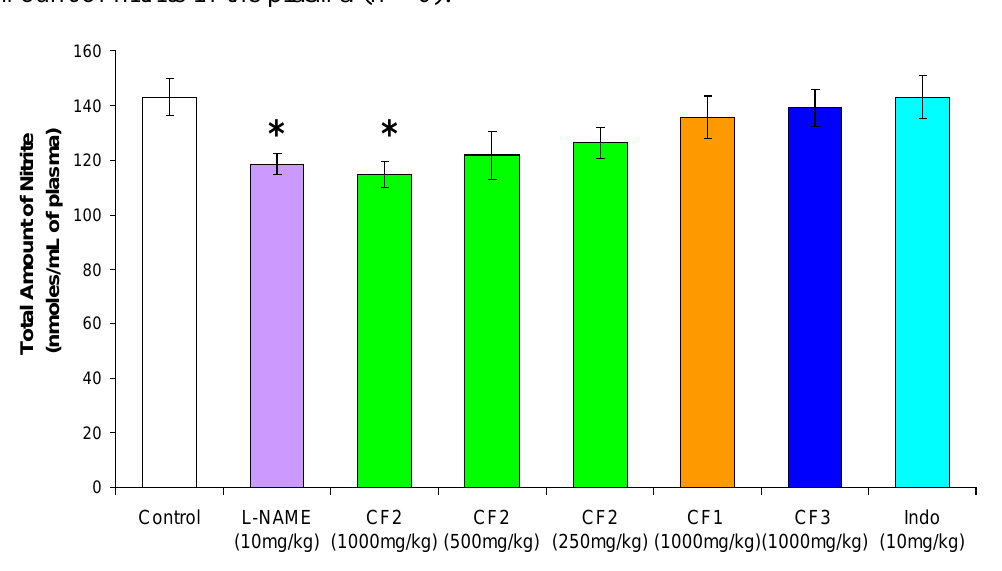
Figure 5. Effects of Orthosiphon stamineus leaf chloroform extract fractions on the total amount of nitrite in the plasma (n =